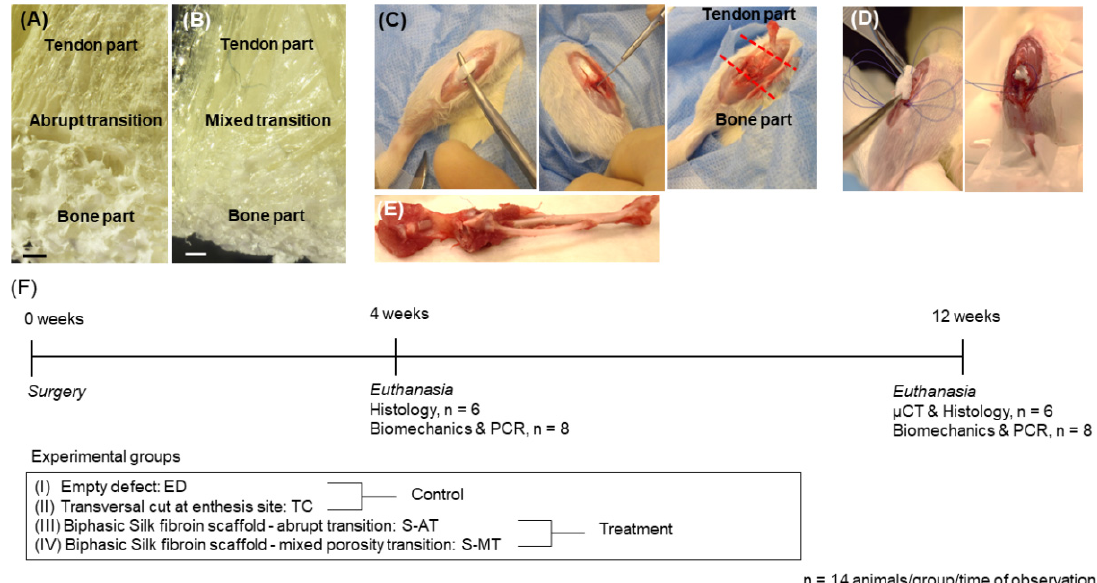
Figure 1. Schematic representation of the surgical approach. ( A , B ) Representative images of the biphasic silk fibroin scaffolds used for treatment, one with an interphase featuring an abrupt transition (S-AT) and one with an interphase presenting a mixed transition (S-MT; B ). Scale bars represent 1 mm. ( C ) Exposure of the tendon and localization of the enthesis. Creation of the enthesis defect. ( D ) Scaffold implantation and fixation. ( E ) Representative image of the sample harvested at 12 weeks after surgery. ( F ) Timeline of surgery and subsequent times of observation. Specimens were col- lected for histology (n = 6) and biomechanics and PCR (n = 8). Samples at 12 weeks were also ana- lyzed by µCT.